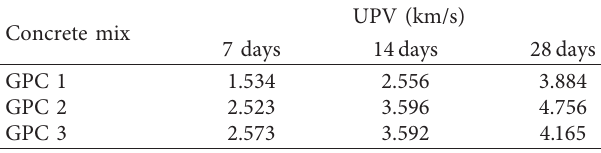
Table 9: UPV values for GPC.